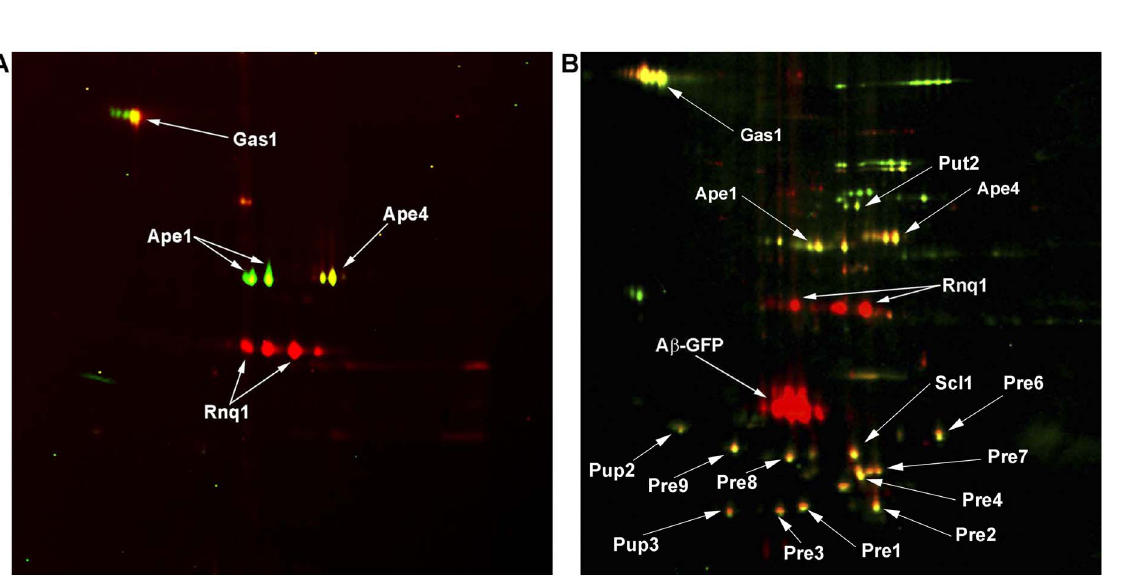
Fig. 2. 2D-DIGE image of proteins of SDS- (A) or sarkosyl-insoluble (B) aggregates isolated from the BY4742 [ PIN + ] strain expressing A b -GFP and from its [ pin 2 ] derivative expressing non-fused GFP. Spots corresponding to proteins from [ PIN + ] cells expressing A b -GFP are red, while proteins from GFP-containing cells (control) are green. Yellow spots correspond to proteins present in both compared samples. Proteins identified by mass-spectrometry are indicated. Identification data are presented in Table 1 (SDS-insoluble aggregates) and 2 and 3(sarkosyl-insoluble aggregates). Mass-spectra of identified proteins are listed in S1–S3 Tables,